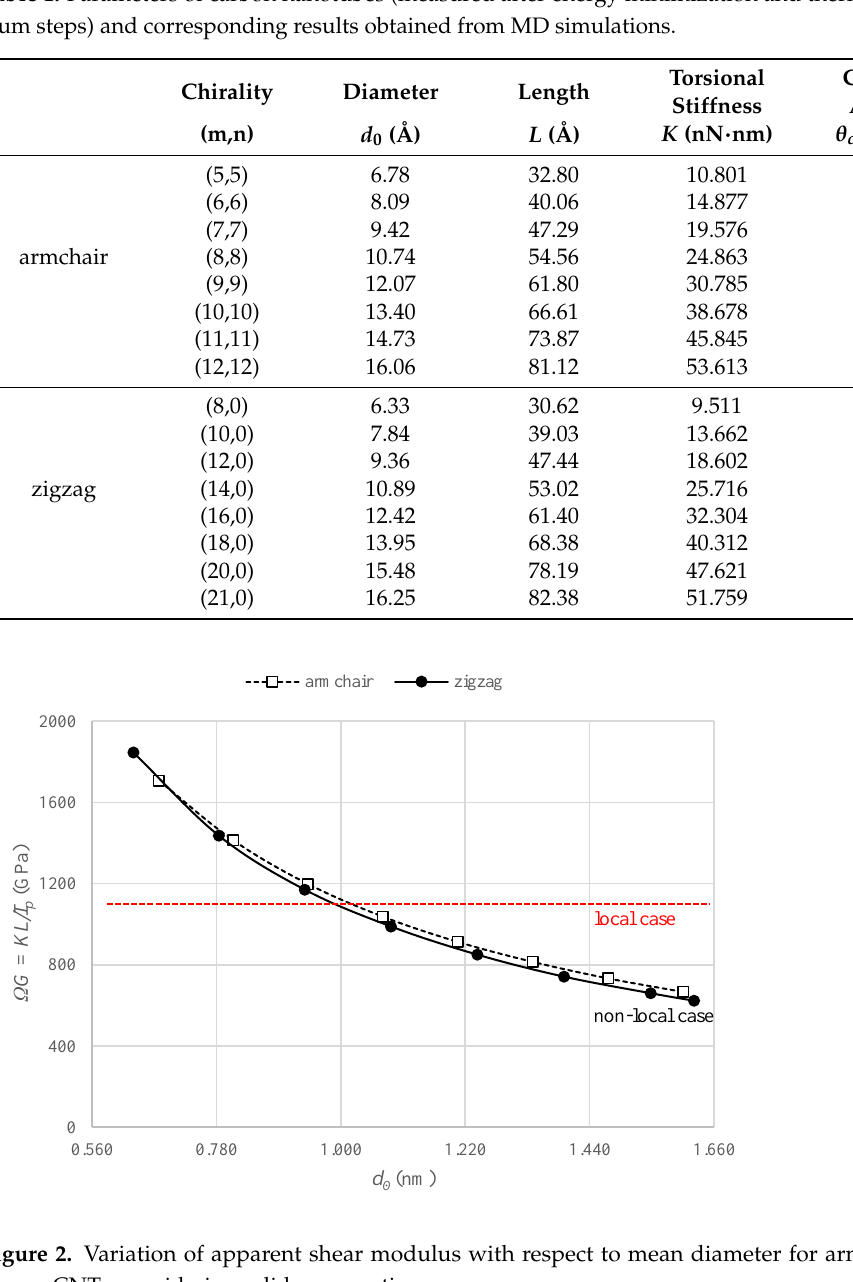
Figure 2. Variation of apparent shear modulus with respect to mean diameter for armchair and zigzag CNTs, considering solid cross